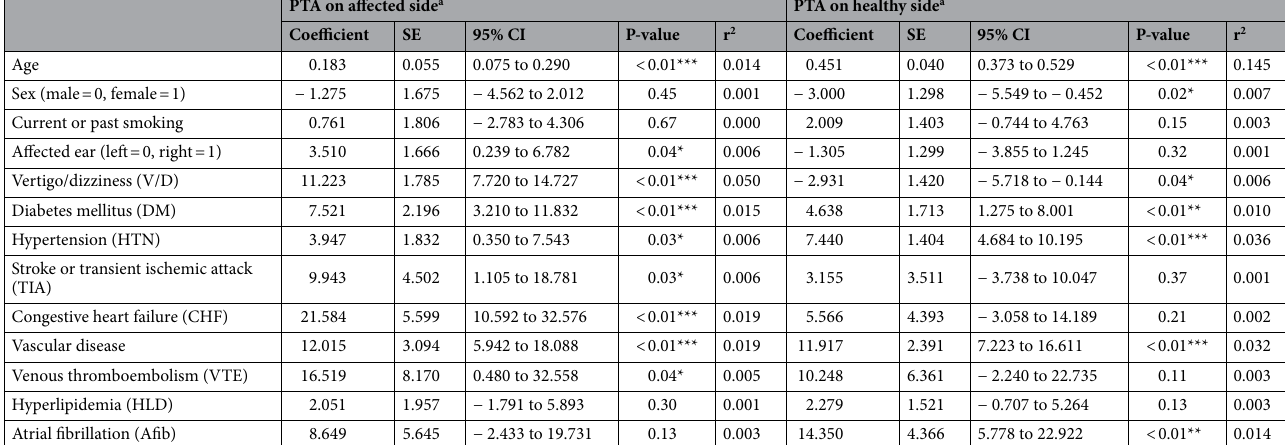
Table 2. Results of univariate regression analysis of atherosclerosis factors and hearing loss (PTA). Coefficient, regression coefficient; CI, confidence interval; SE, standard error of the regression coefficient; other